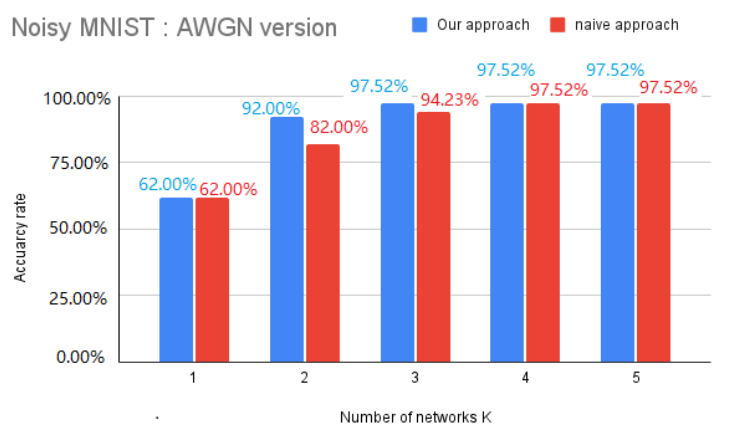
Figure 17. Classification’s accuracy on the MNIST dataset with added white Gaussian noise.